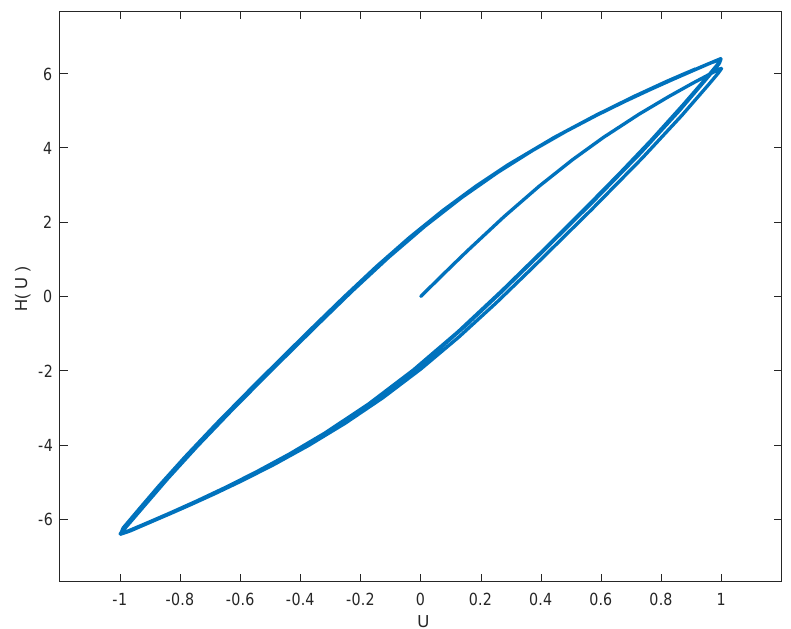
Figure 1. The input hysteresis